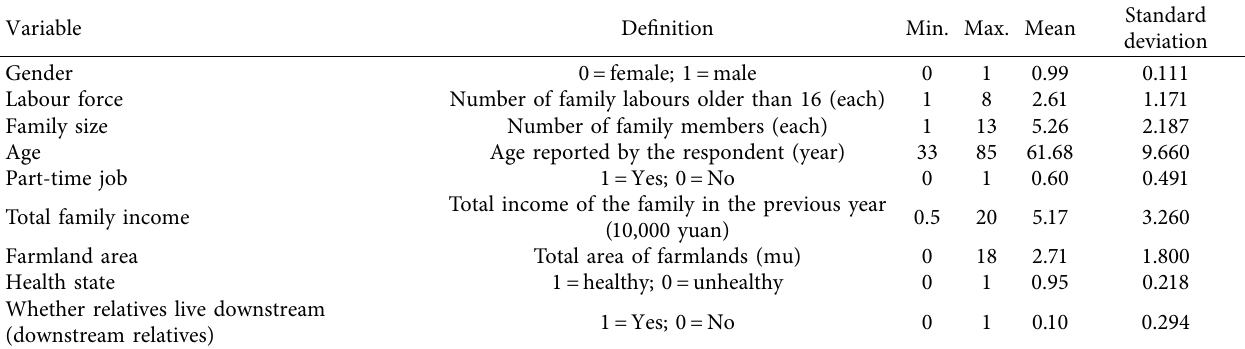
Table 4: Descriptive statistics of individual features of